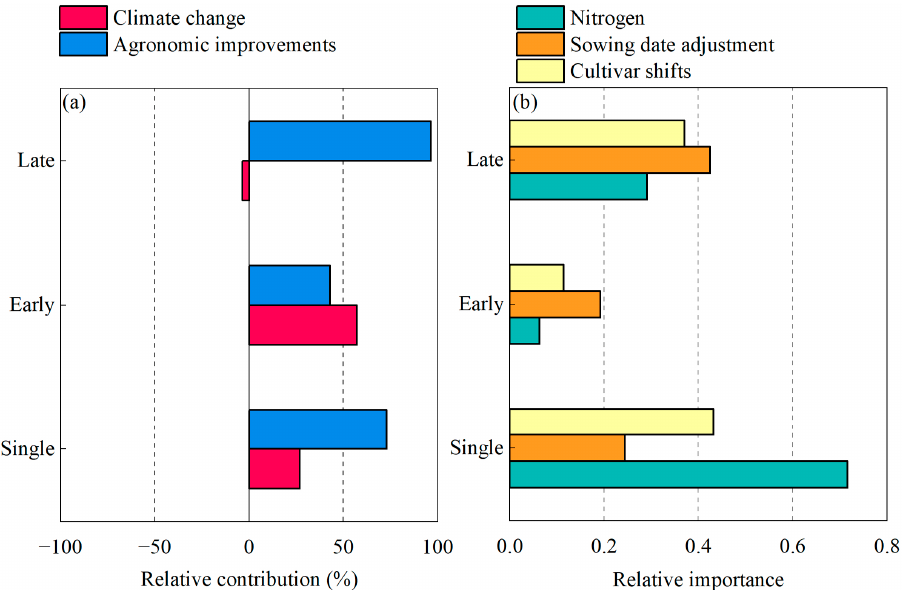
Figure 5. The relative effects of climate change and agronomic improvements on rice yield. ( a ) is the relative contribution of climate change and agronomic improvements. ( b ) is the relative contribution of each measure. Table 2. Summary of adaptation measures for rice agriculture from 1981 to